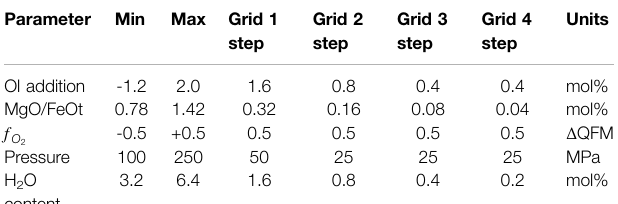
TABLE 3 | Values used to de fi ne the grids of initial parameters.